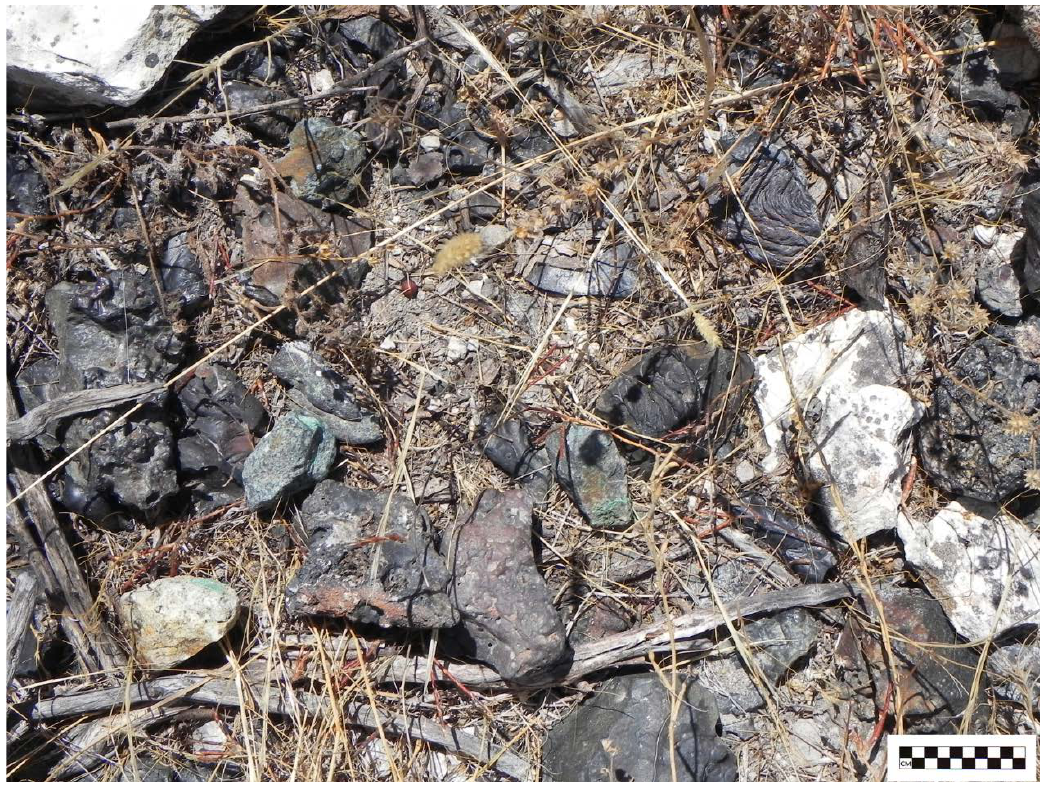
Figure 10. Copper slag concentrations to the east of our survey area (Image by Giorgos Papantoniou).